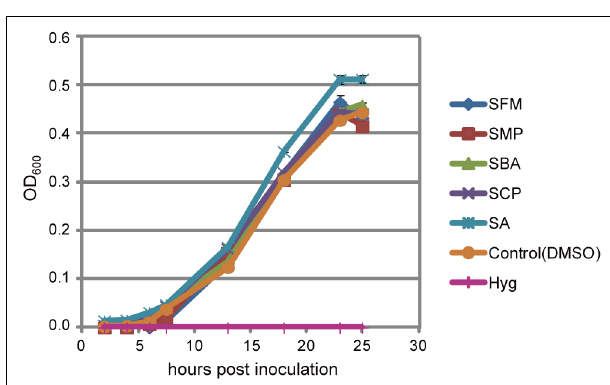
FIGURE 6 | Effect of the sulfonamides on the enzymatic activities of the SAGT. The levels of SA- β - D -glucoside (SAG) in the in vitro enzymatic reaction using affinity-purified histidine-tagged recombinant Arabidopsis UGT74F1 protein expressed in E. coli were measured by HPLC.The sulfonamides and imprimatin A2 were provided at a concentration of 100 μ M.The data are shown as values relative to the DMSO control.The bars represent the mean ± SE values of three independent replicates.